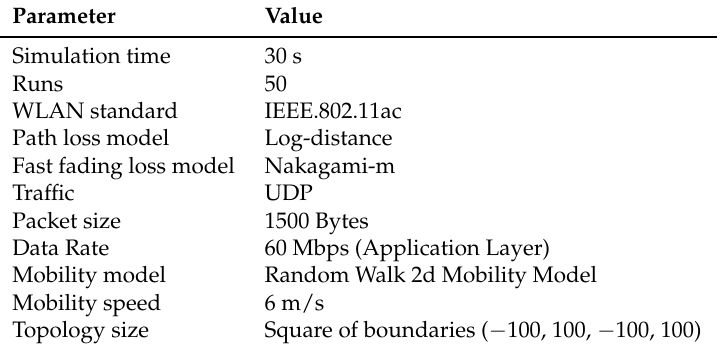
Table 3. Summary of simulation parameters.